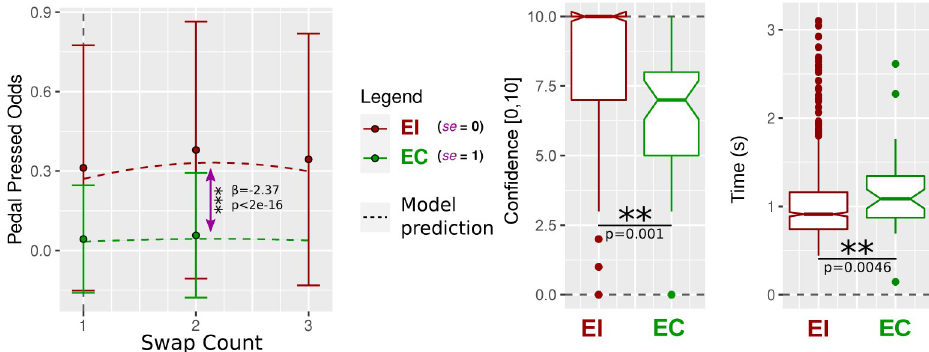
Fig 5. Plots of the results from the analysis section. (a) H1—Probability of pressing the pedal after the introduction of a finger swap, for swap count of 1 (e.g., swap index finger with middle finger), 2 (e.g., index finger with ring finger), and 3 (index finger with little finger, this occurred only for the EI condition, i.e., there is no data-point for EC ). Plots of the mixed model prediction (dashed lines) compared to all subjects’ data. The pink arrow highlights the significant difference resulting from the se fixed effect. (b) H2a.—Effects of EI and EC conditions in terms of confidence levels. The EI condition presents a very significantly higher confidence score than the EC condition. (c) H2b.—Effects of EI and EC conditions in terms of reaction times. The EI condition presents a very significantly shorter reaction time than the EC condition. (Two additional outliers at 9.1s and 3.9s are out of the plot for EI